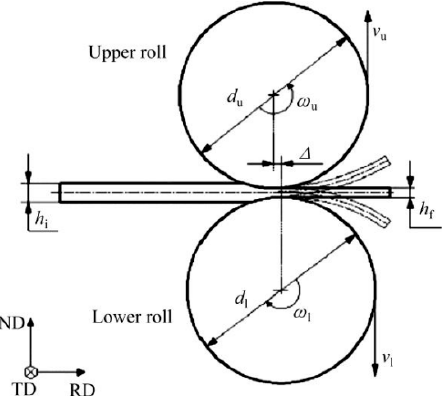
Figure 20. Schematic diagram of snake rolling. Adapted with permission from ref. [95]. 2016 Li et al.